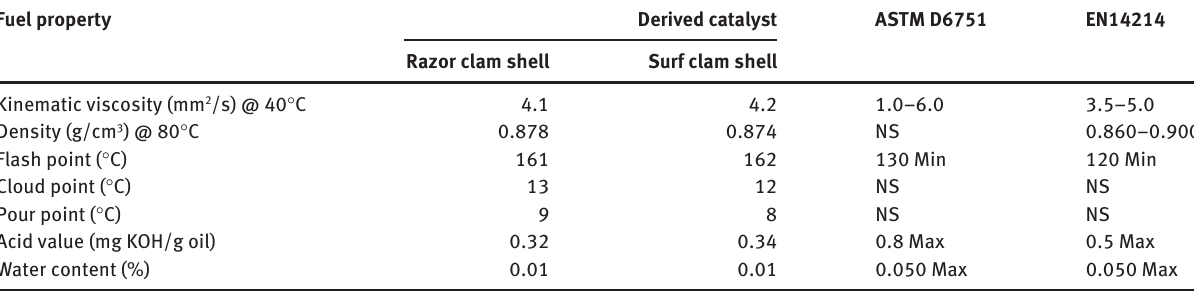
Table 3: The fuel properties of biodiesel. Fuel property Derived